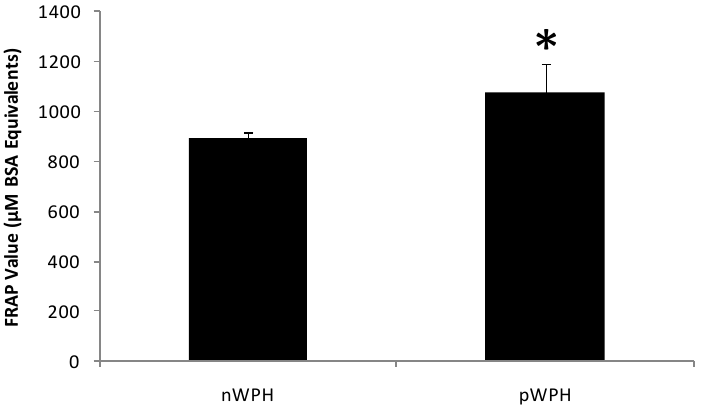
Figure 5. Effect of high hydrostatic pressure on the ferric-reducing antioxidant power (FRAP) of WPH. Freeze-dried hydrolysates resulting from the in vitro digestion and subsequent ultrafiltration were reconstituted in ddH 2 O at a concentration of 10 mg/mL and incubated with the FRAP reagent for 90 min at a 1:30 ratio. BSA was used to construct a standard curve and absorbances were read at 593 nm. Results are expressed in μM BSA equivalents ± SEM. (*) Indicates a statistically significant difference ( p < 0.05).